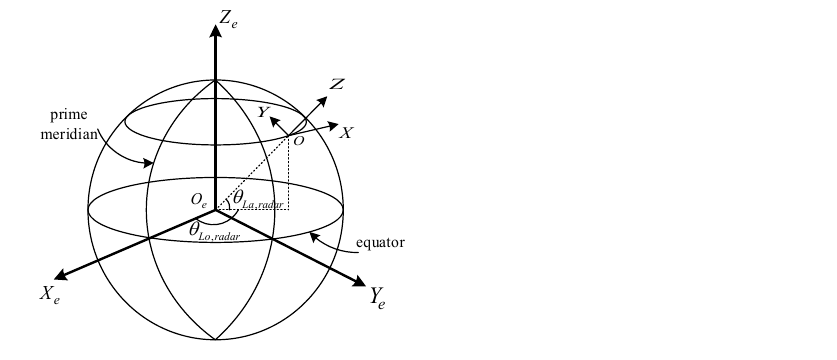
Figure 3. Earth ‐ fixed coordinate system and radar local coordinate system. Figure 3. Earth-fixed coordinate system and radar local coordinate